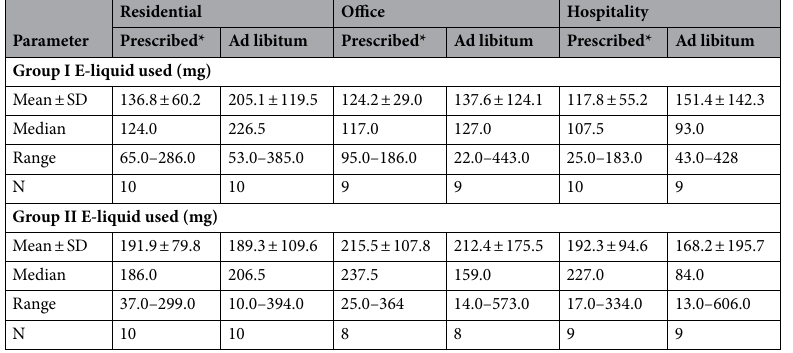
Table 2. E-liquid used during prescribed and ad libitum product use for Groups I and II. *In addition to the 80 puffs taken during prescribed use, an additional 20 puffs were taken prior to weighing the pods, so values represent 100 puffs.